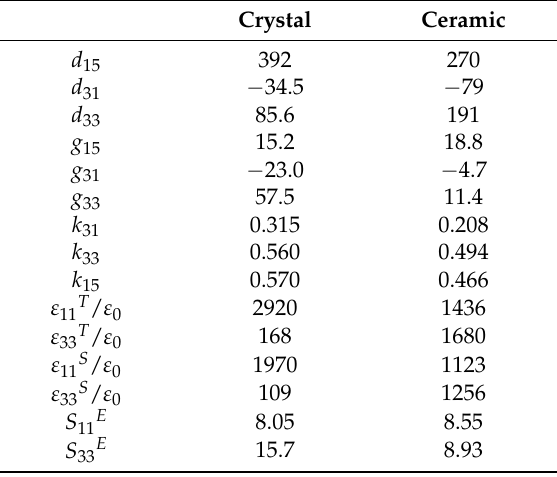
Table 2. Piezoelectric coefficients for BaTiO 3 single crystal and ceramic.